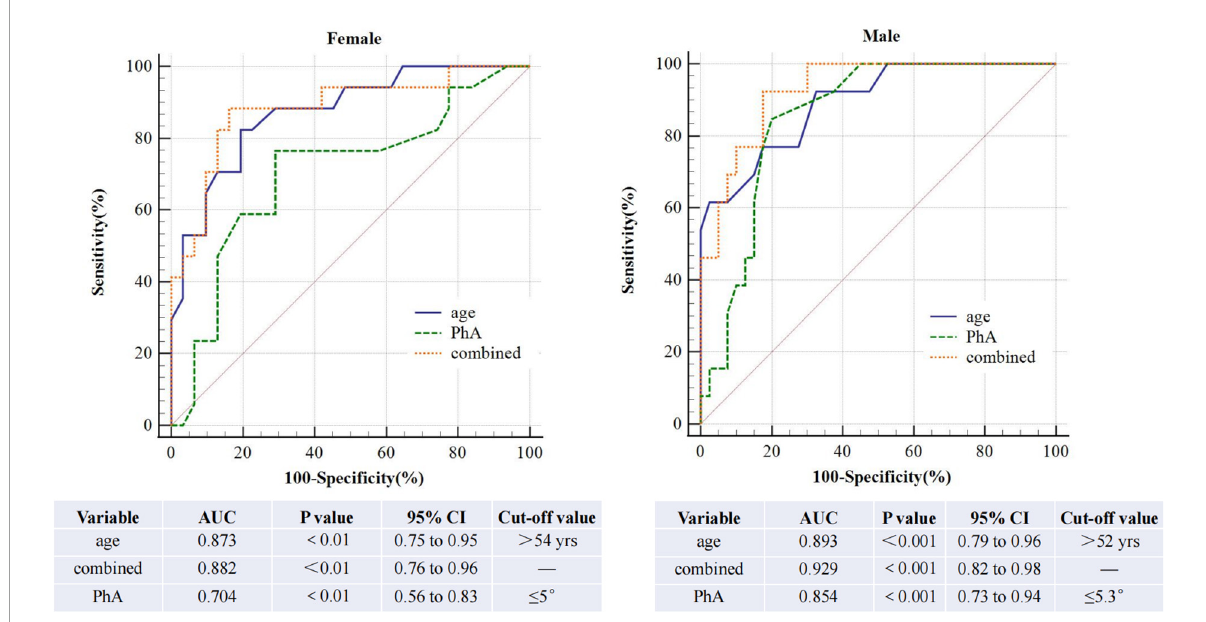
FIGURE4 Roc curve comparison of three diagnostic indicators in females and